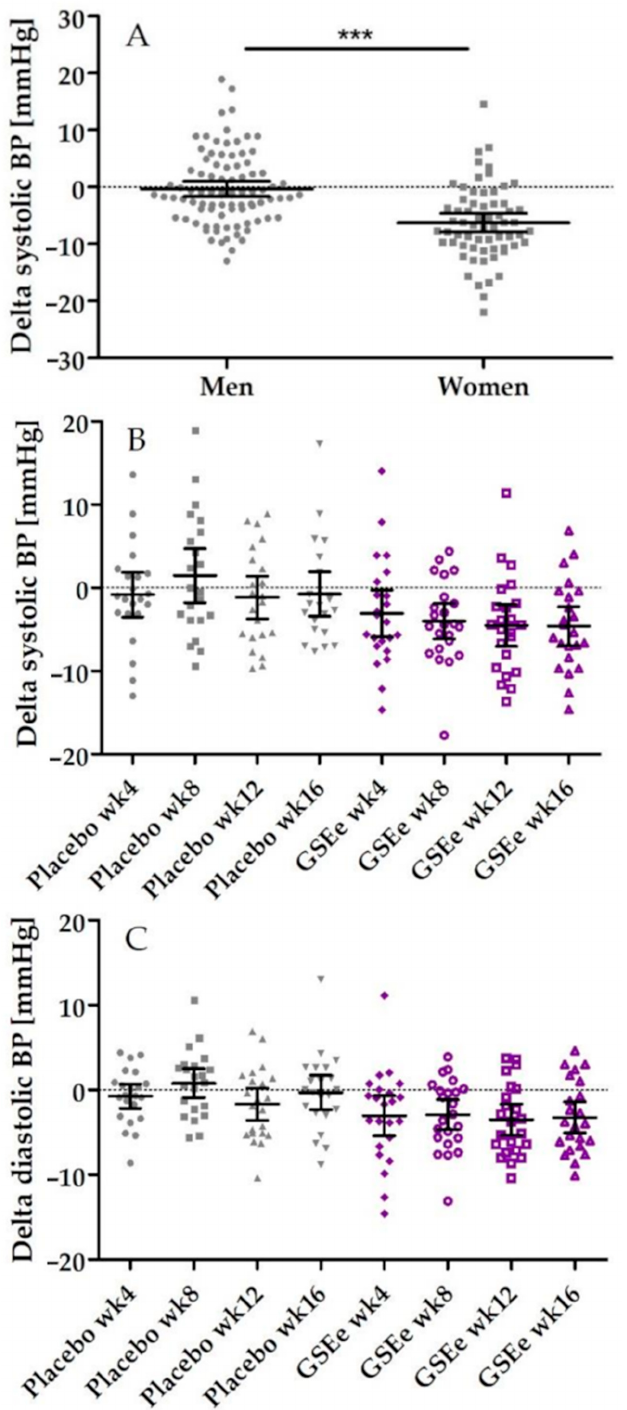
Figure 5. Distribution of delta changes of blood pressure interactions between gender and supple- mentation. ( A ). Distribution of delta change of 7-day diary of systolic blood pressure measurement after 4, 8, 12, and 16 weeks in comparison to baseline assessment in men and women during placebo intake summarized for all assessment time points. ( B ). Distribution of delta changes of 7-day diary of systolic blood pressure assessment in men in comparison to baseline assessment. ( C ). Distribution of delta changes 7-day diastolic blood pressure in men in comparison to baseline assessment. Grey: placebo, purple: GSEe group [in mmHg]. All data pooled for 4-week, 8-week, 12-week and 16-week assessment (panels ( B , C )). Scatter diagram with mean ± 95 % C.I.; *** = p <